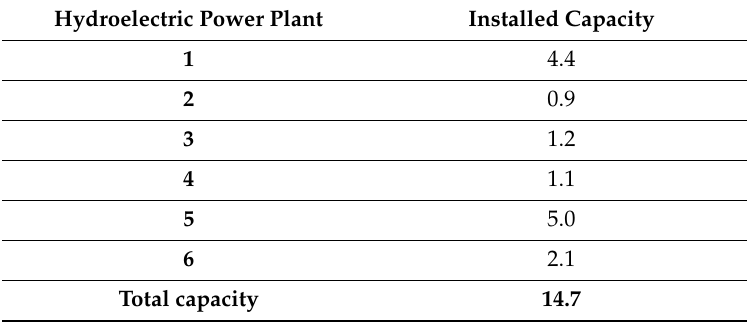
Table A2. Installed capacity of hydroelectric plants (MW).